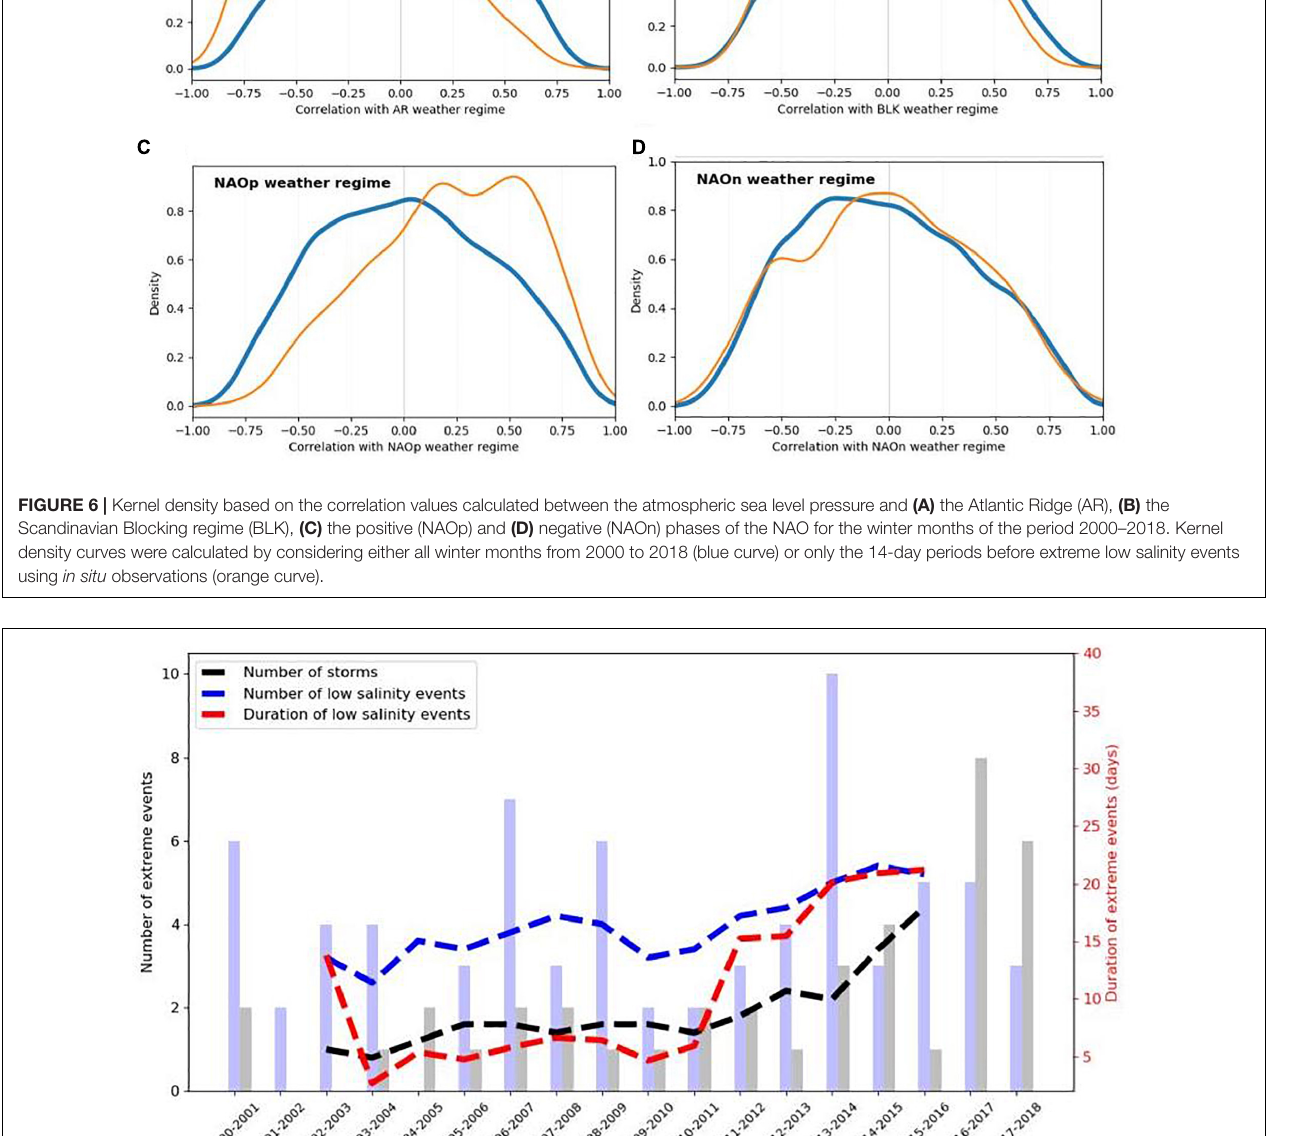
ocean water mass exchanges between the bay and the Iroise